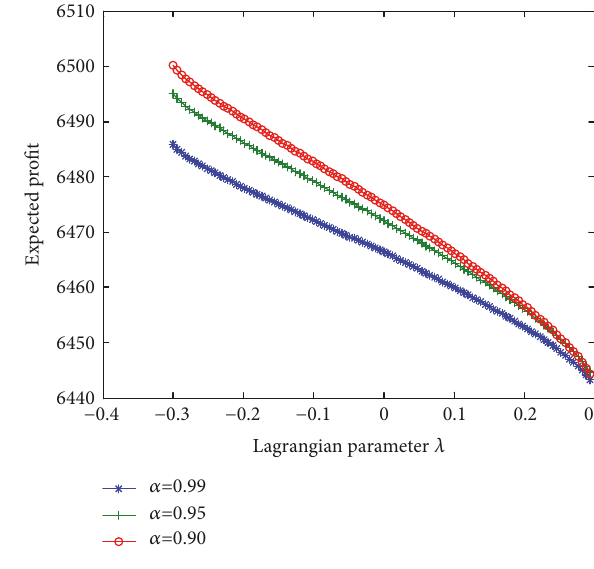
Figure 6: The expected returns under different 𝜆 .